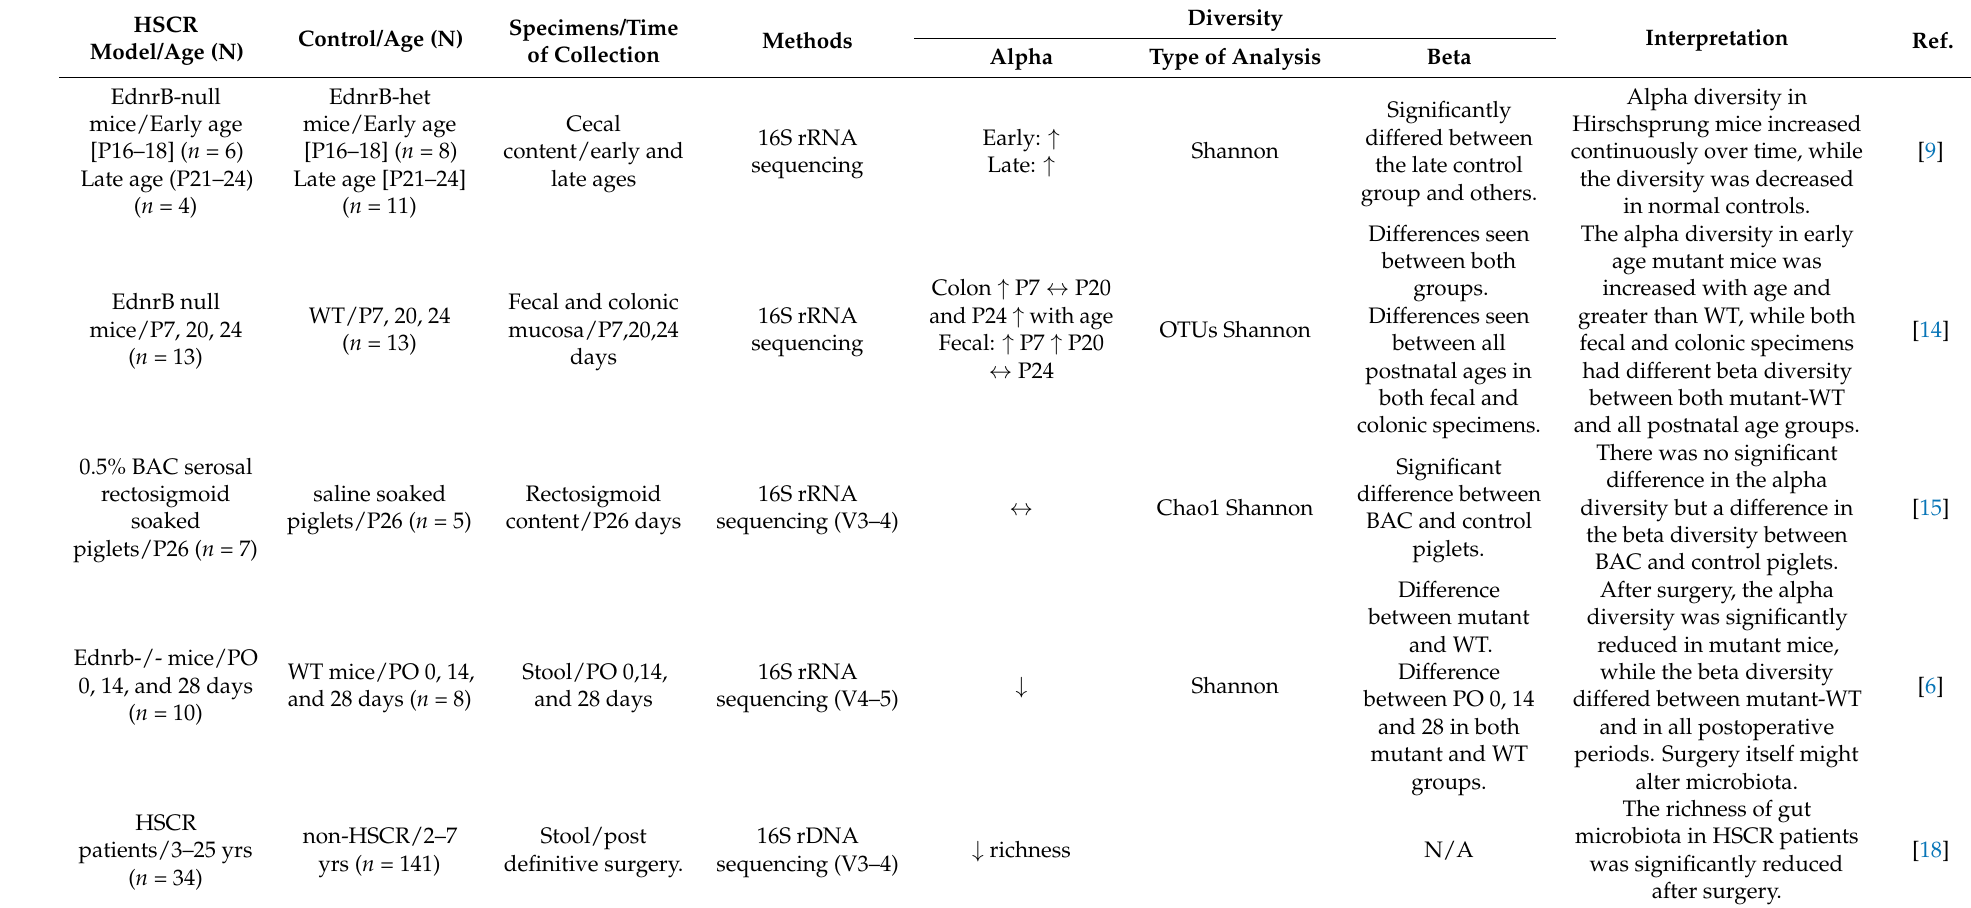
Table 1. The comparison of the diversity in gut microbiota between subjects with Hirschsprung disease (HSCR) and healthy controls: Evidence from animal to clinical